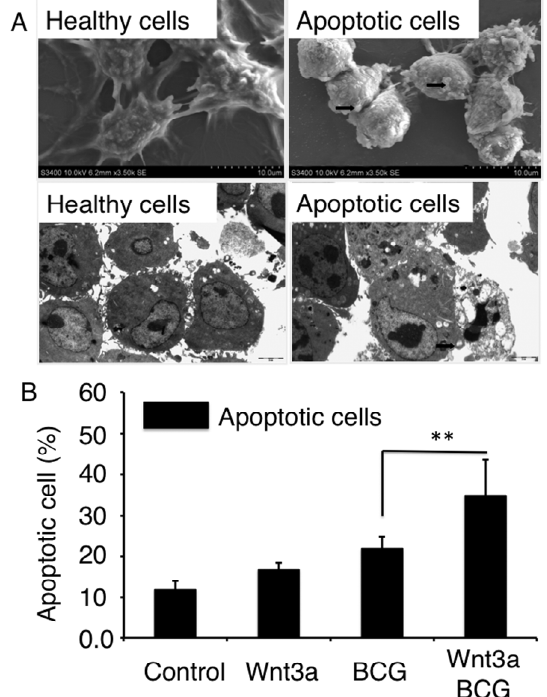
Figure 3. Morphological analysis of the impact of Wnt3a on BCG-infected RAW264.7 cells apoptosis. RAW264.7 cells exposed to Wnt3a-CM or control-CM, followed by infection of BCG at MOI of 10 for 24 h. ( A ) Representative images of SEM ( top panel ) and TEM ( bottom panel ) of healthy RAM264.7 cells ( left panel ) and apoptotic cells ( right panel ); ( B ) Percentages of cells with an apoptotic phenotype as determined by morphology using EM images. Compared to a naïve control, ** p < 0.01. Data represented the mean ± SD from three independent triplicated experiments ( n = 9). Bar in SEM images = 2 µm; Bar in TEM images = 10 µm. Arrows in A indicated apoptotic